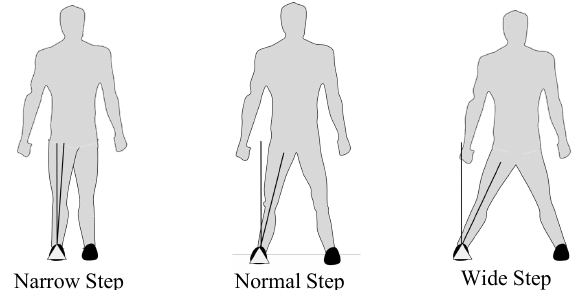
Figure 14. The variation of the angle of the ankle in the front plane depending on the step